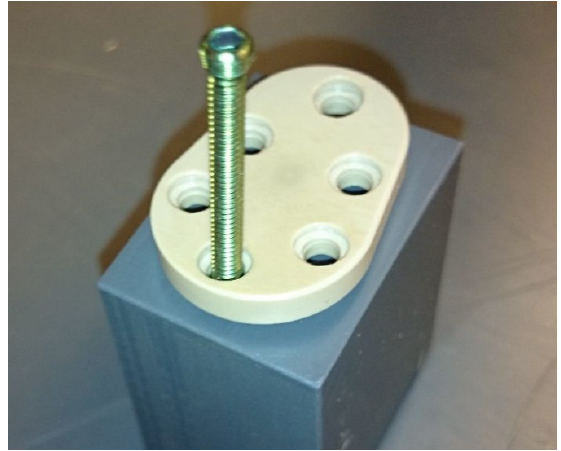
Figure 10. Fixing the test implant at the test block (represented is only one screw before insertion, the test implant was fixed with three screws). test implant was fixed with three